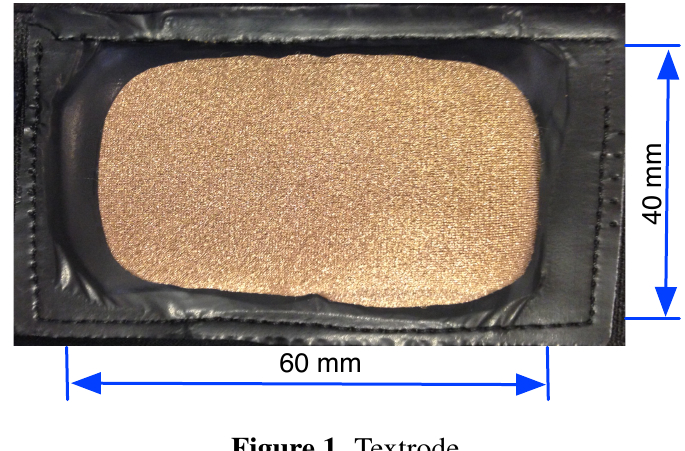
Figure 1. Textrode.